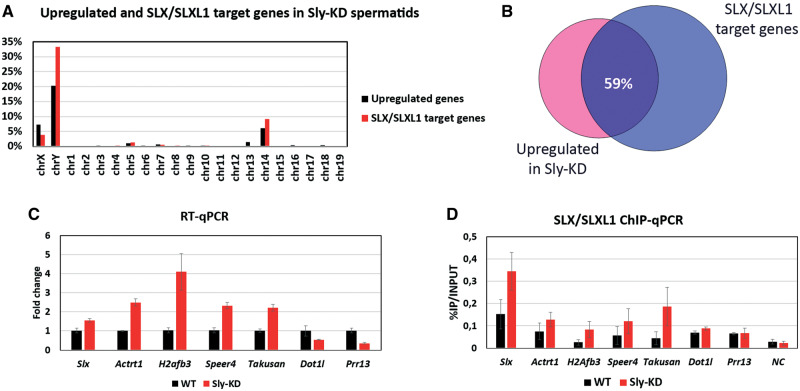
Genes enriched in SLX/SLXL1 are upregulated in Sly-KD round spermatids. (A) In black: location of upregulated genes identified Sly-KD compared with WT spermatids (>1.5×, P < 0.05 from Cocquet et al. [2009]; revisited in Moretti et al. [2017]). In red: location of SLX/SLXL1 target genes identified by ChIP-Seq (in common in the three SLX/SLXL1 ChIP-Seq Exp on Sly-KD round spermatids). (B) Venn diagram representing the percentage of genes found upregulated in Sly-KD spermatids that are among SLX/SLXL1 target genes (in common in the three SLX/SLXL1 ChIP-Seq Exp on Sly-KD round spermatids). (C, D) Examples of genes that are enriched in SLX/SLXL1 and are upregulated in Sly-KD round spermatids. (C) RT-qPCR quantification performed on WT and Sly-KD round spermatids. The graph represents the mean ± SEM (after normalization with β-actin, n = 3–4 samples per genotype). For all, a significant difference between Sly-KD and WT samples was found (t-test, P-value < 0.05). RT-qPCR data for Actrt1 are from Cocquet et al. (2012); RT-qPCR data for H2afb3 and Dot1l are from Moretti et al. (2017). (D) SLX/SLXL1 ChIP-qPCR performed on WT and Sly-KD round spermatids. The Y-axis represents the mean enrichment (% IP/input) ± SEM (n = 3–4 samples per genotype).